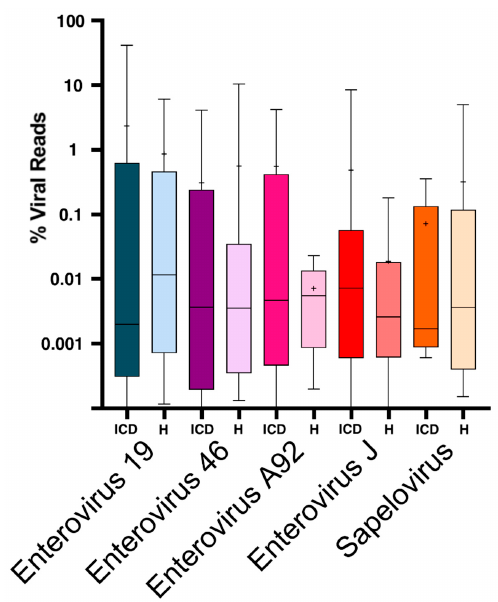
Figure 2. Box and whisker plot of the % viral reads for the five most prevalent viruses. Healthy control animals are labeled H while sick animals are labelled ICD. Boxes indicate the limits of the